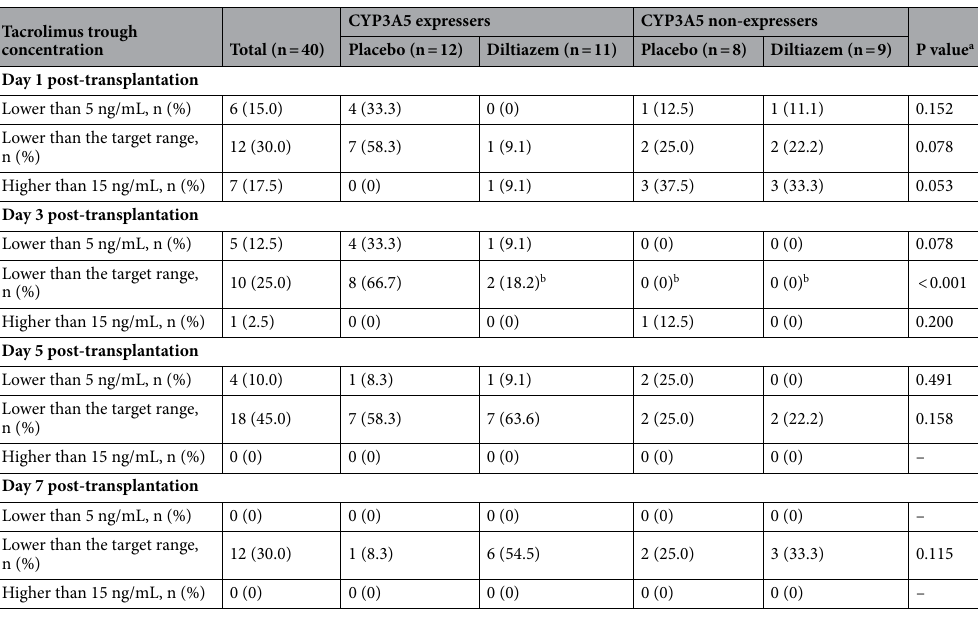
Table 4. Proportions of kidney transplant recipients with a markedly subtherapeutic or supratherapeutic tacrolimus trough concentration during the first week after kidney transplantation. a Fisher’s exact test. b P < 0.05 versus CYP3A5 expressers with placebo group (Bonferroni correction for multiple comparisons).